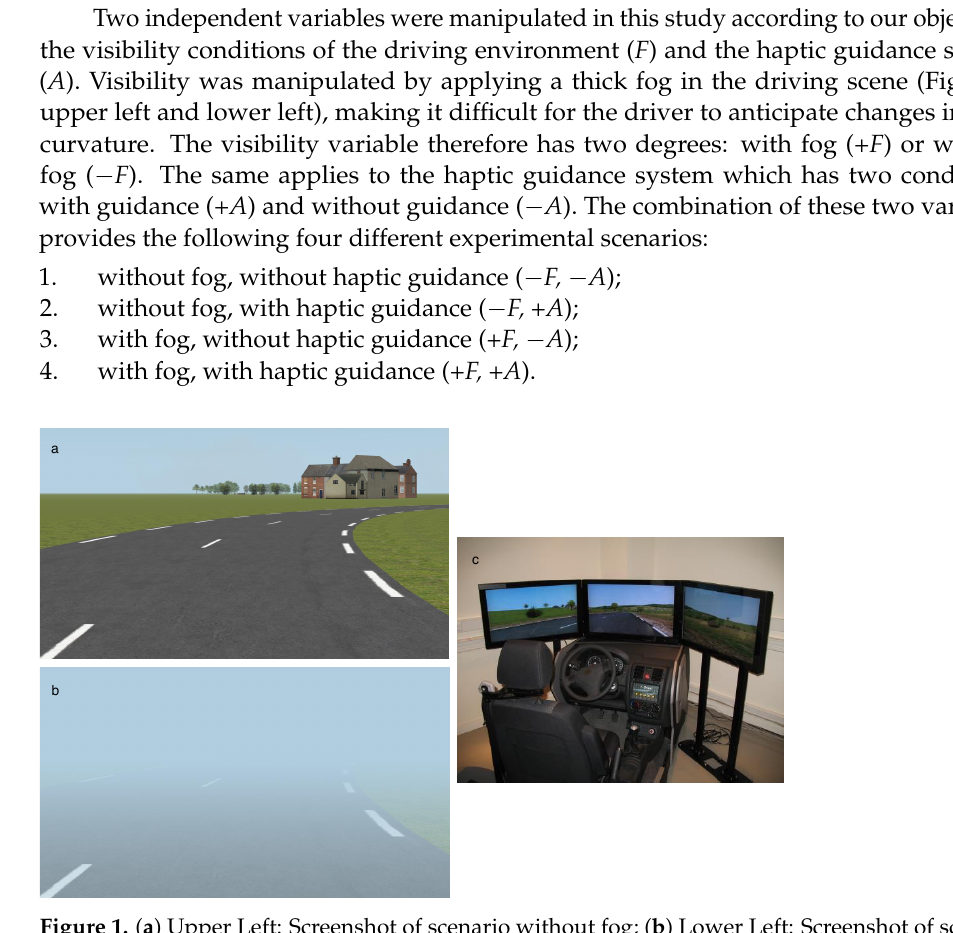
Figure 1. ( a ) Upper Left: Screenshot of scenario without fog; ( b ) Lower Left: Screenshot of scenario with fog; ( c ) Right: Fixed base driving simulator